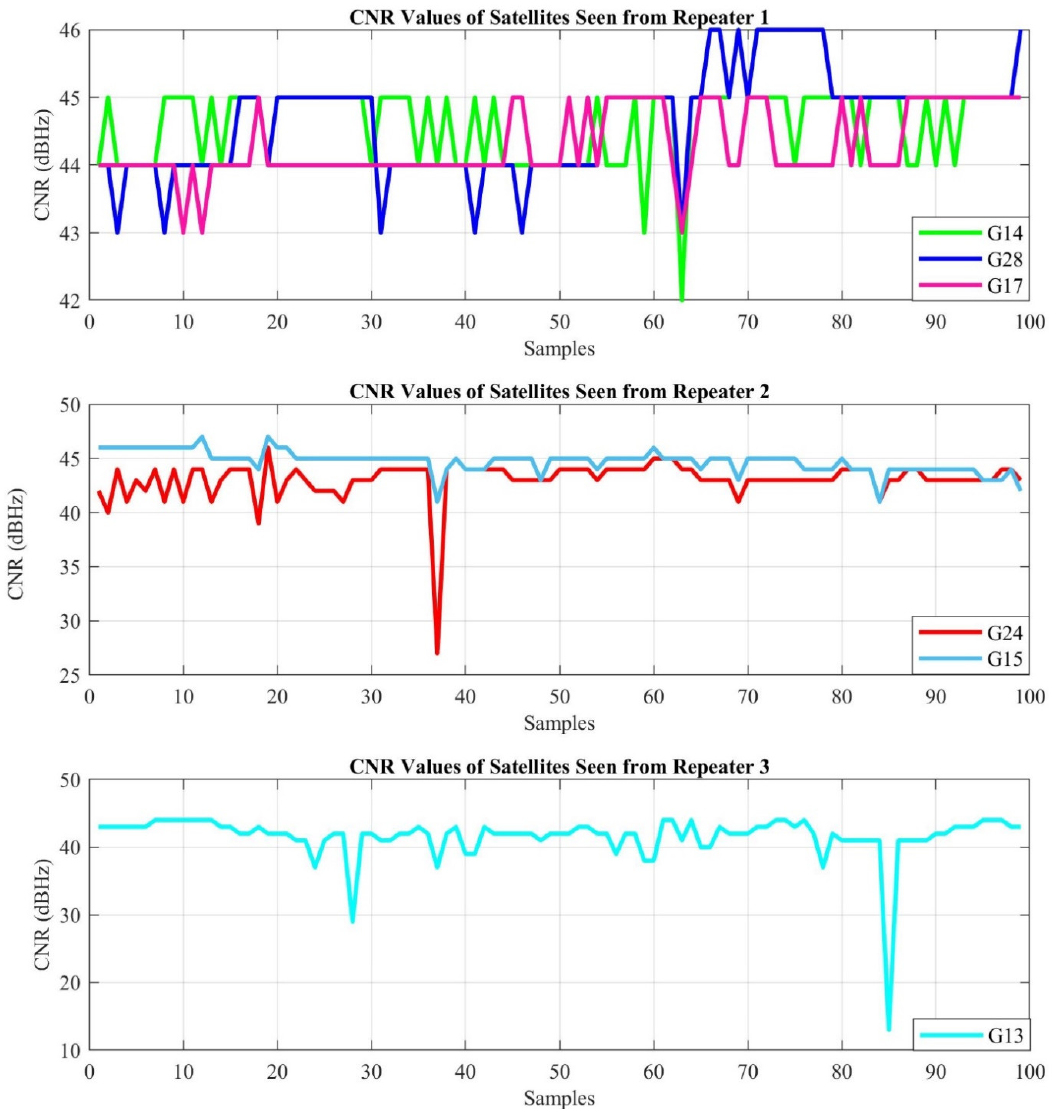
Figure 13. CNR of each GPS signal received by the repeaters.